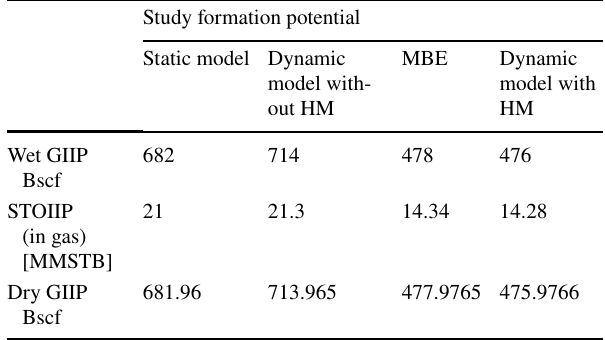
Fig. 16 Core samples shows Bitumen occupied matrix pores